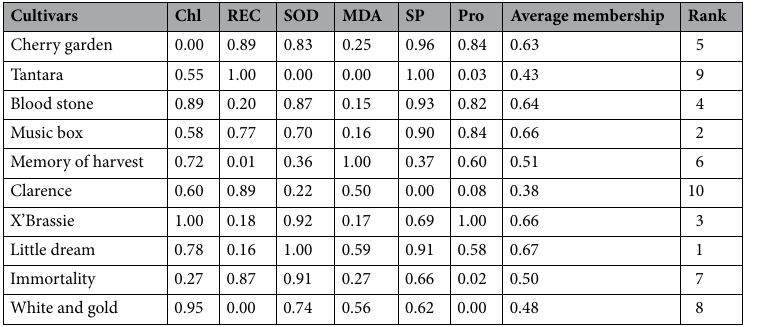
Table 1. Value for membership function for I. germanica. Chl, chlorophyll; REC, relative electric conductivity; SOD, superoxide dismutase; MDA, malondialdehyde; SP, soluble protein; Pro, free